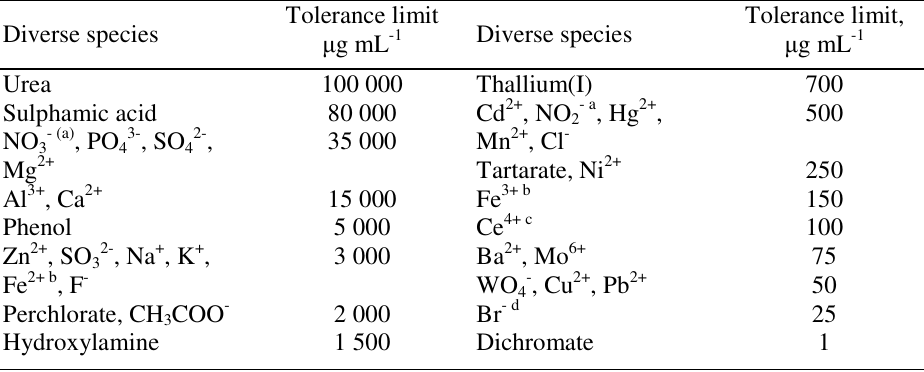
Table 3. Effect of diverse ions on the spectrophotometric determination of Thallium(III) (2 µ g mL -1